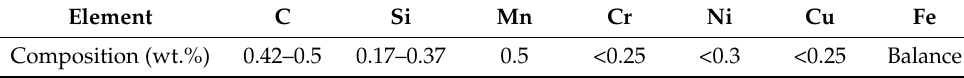
Table 1. Chemical composition of AISI1045 # carbon steel